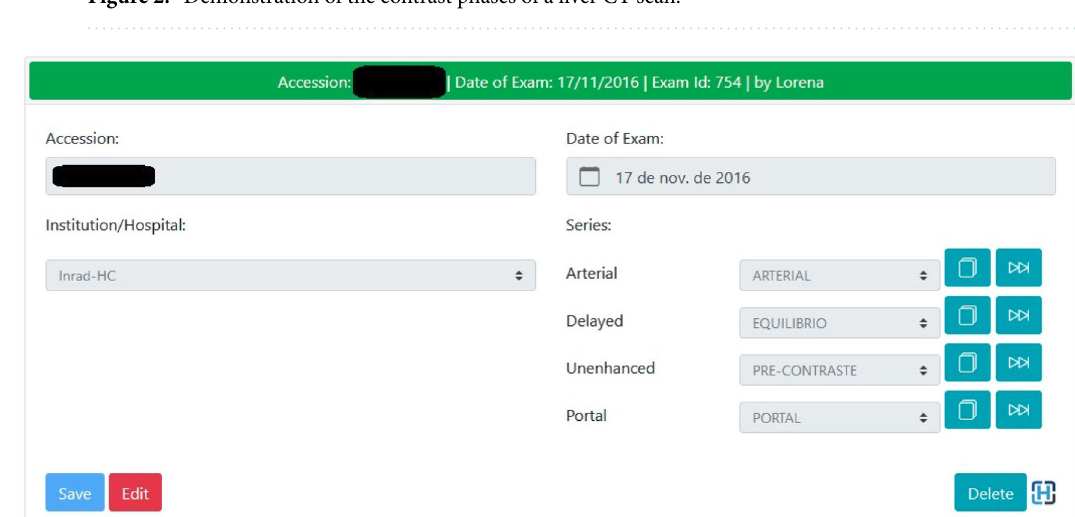
Figure 3. HepatIA platform liver tomography contrast phase annotation